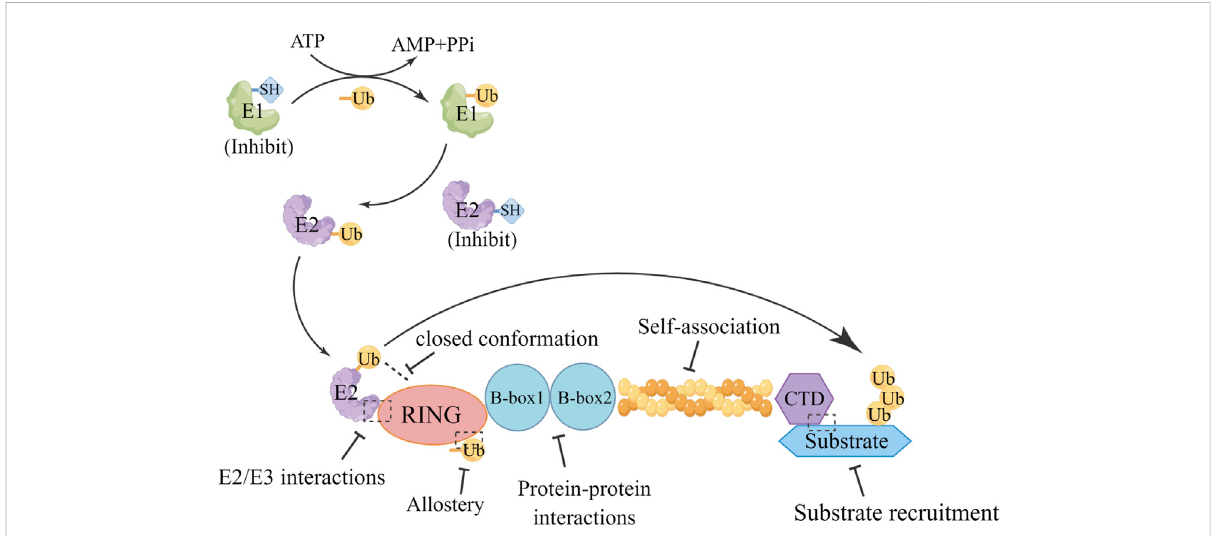
FIGURE 6 Targeting options for TRIMs. Exploring the interactions between TRIM protein domains reveals potential targeting strategies for TRIMs, which may be applied to the design of drugs targeting TRIMs.There are several strategies to consider for drugs targeting TRIMs, Targeted drugs were designed through E2/E3 interactions, closed conformations, allostery, protein-protein interactions, self-association, and substrate